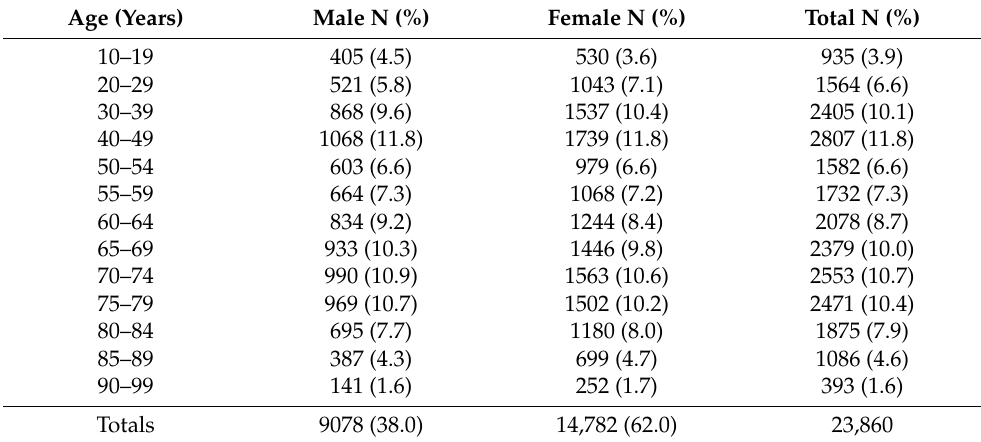
* Included participants had a left-right ear hearing-threshold difference of ≤ 15 dB at 250, 500, 1000, 2000, and 4000 Hz and had an air-bone gap of <10 dB. For some age brackets, we show the data by lustrum or 5-year bins.